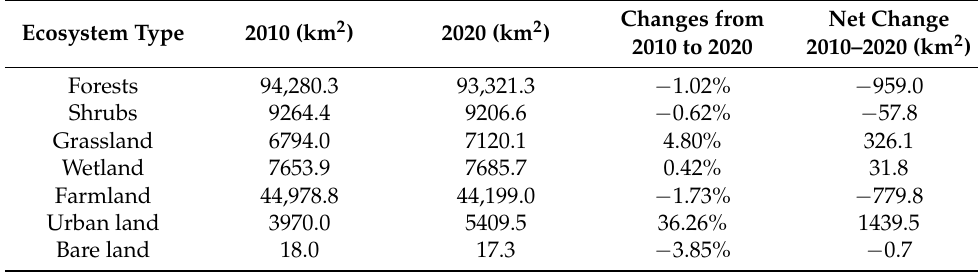
Table 3. Area and change of ecosystem types in Jiangxi Province (2010–2020).